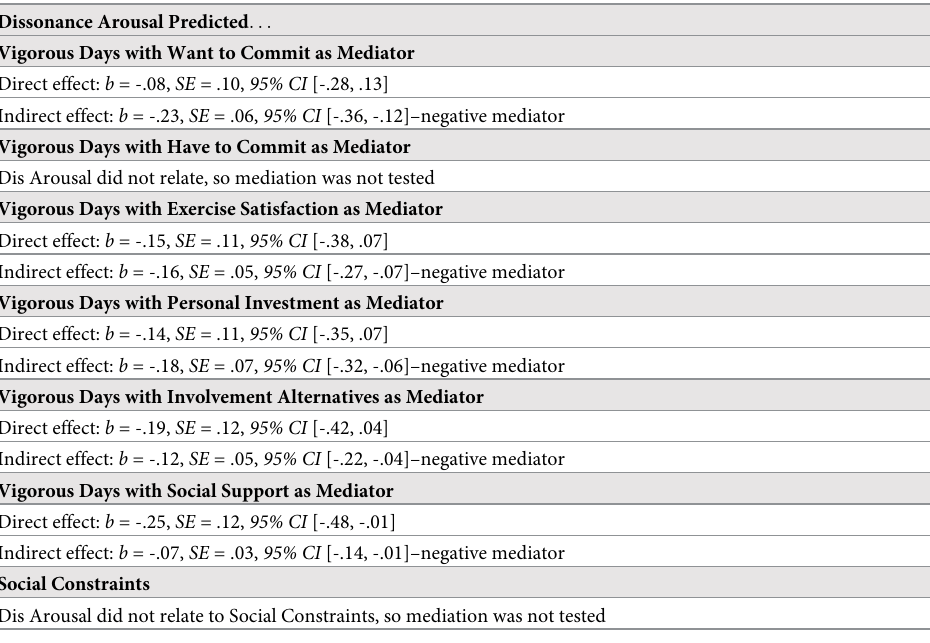
Table 20. Mediational analyses for dissonance arousal and days of exercise (Study 3). Dissonance Arousal Predicted ... Vigorous Days with Want to Commit as